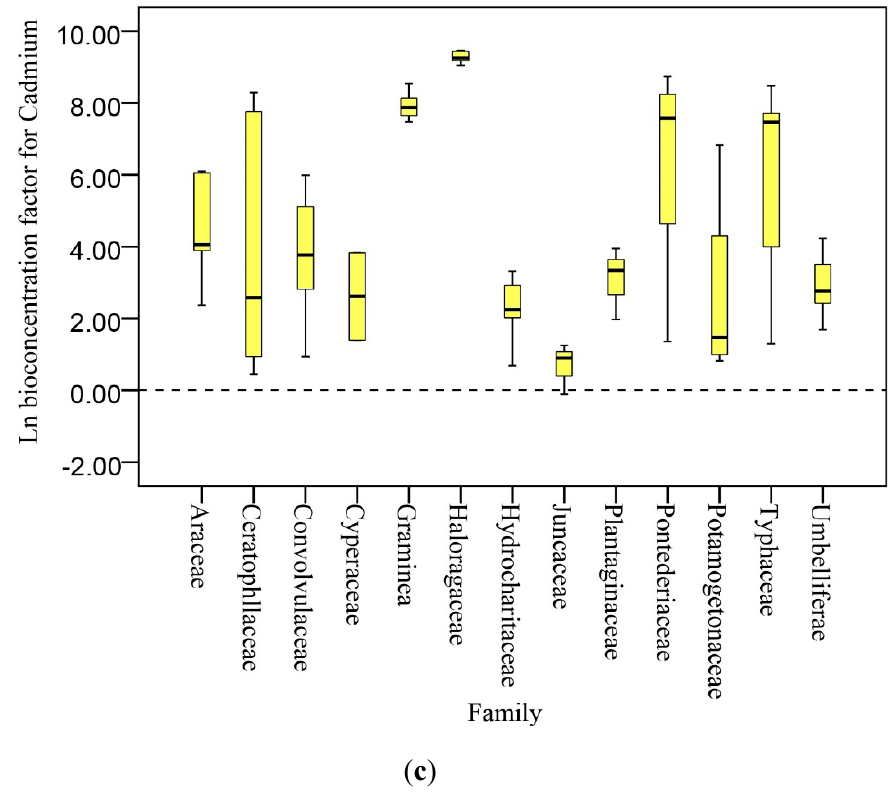
Figure 1. ( a ) Bioconcentration of copper by aquatic plants belonging to 13 families. ( b ) Bioconcentration of zinc by aquatic plants belonging to 18 families. ( c ) Bioconcentration of cadmium by aquatic plants belonging to 13 families. The Ln BCF is noted for each study. The whiskers represent the range, the hinges represent the inter-quartile range (IQR), and the middle line represents the median. The mean ( µ ) BCF for Cd was similar across all 13 plant families ( n = 84, median = 4, min = ´